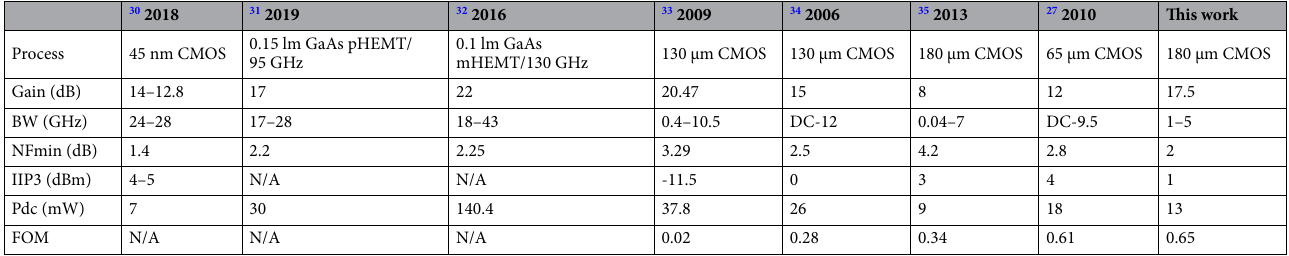
Table 2. Performance summary of UWB CMOS